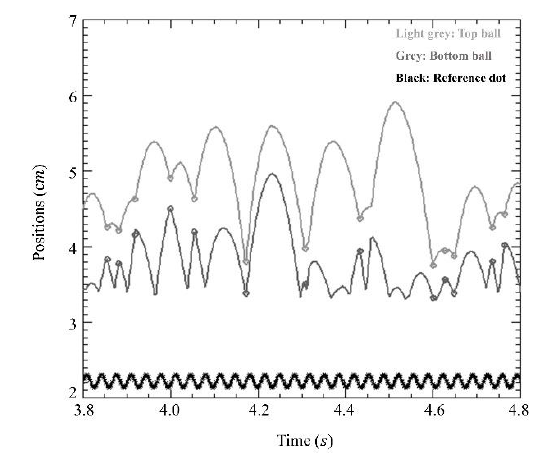
Fig. 2. Ball and plate positions plotted versus time.